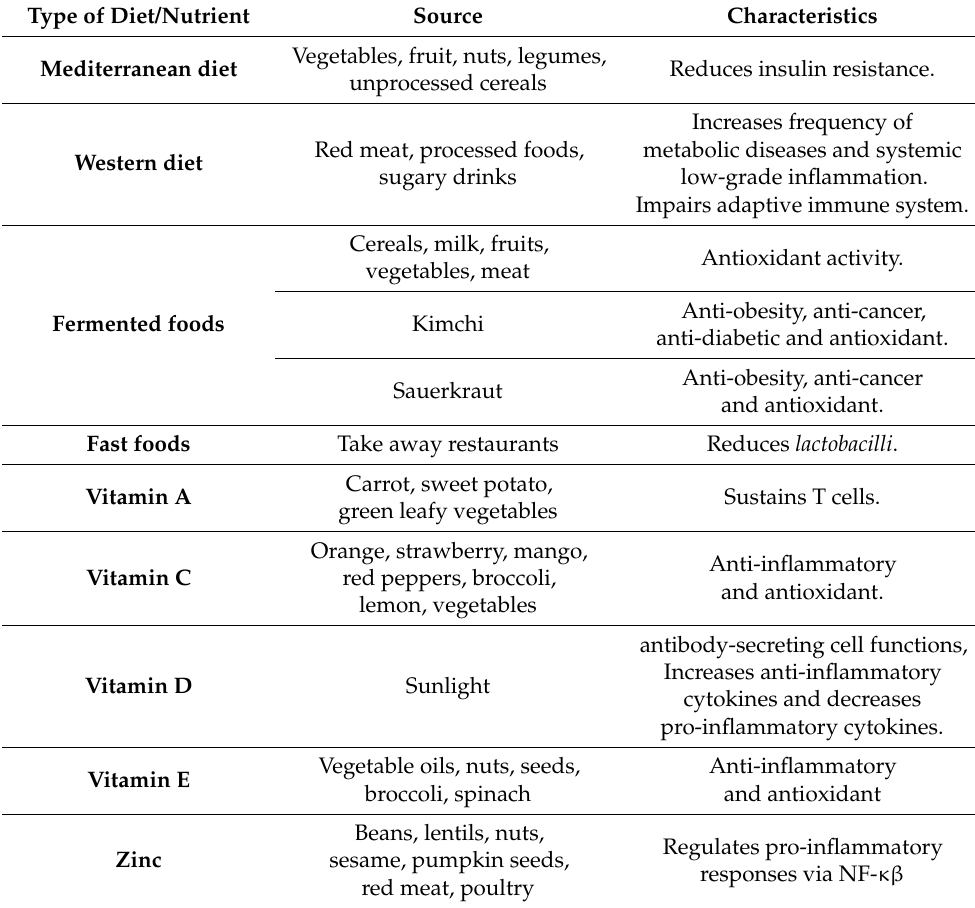
Table 1. The source of various nutrients and diets and their effects on health. Type of